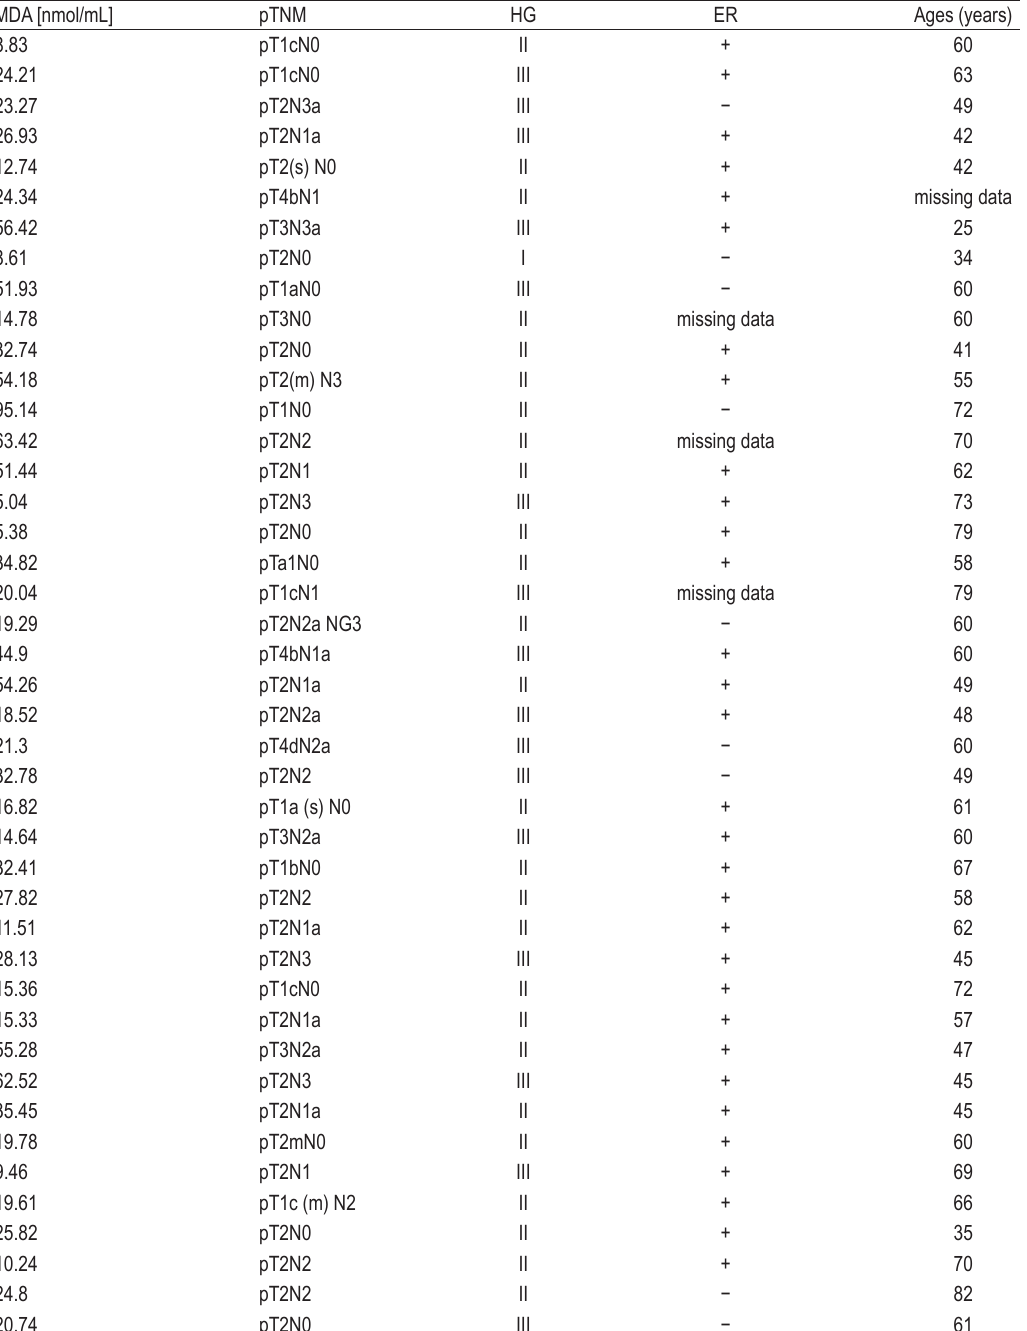
TABLE 3. pTNM status, HG, ER status, ages and MDA serum levels in breast cancer